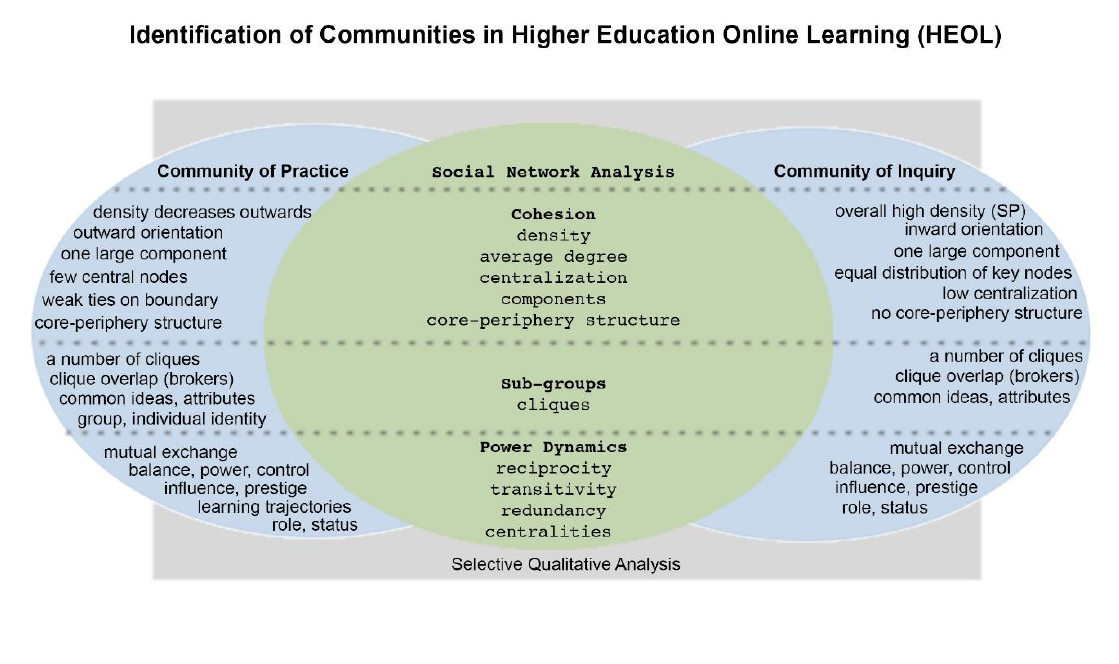
Figure 1. Integrated methodological framework